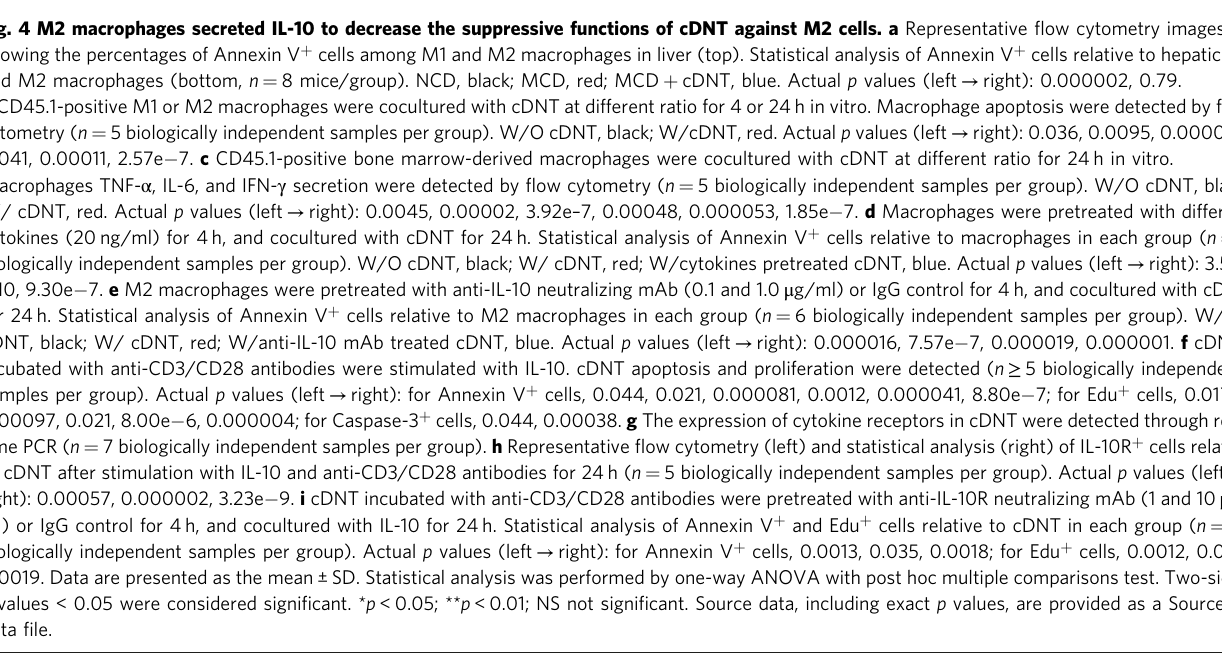
Fig. 4 M2 macrophages secreted IL-10 to decrease the suppressive functions of cDNT against M2 cells. a Representative fl ow cytometry images showing the percentages of Annexin V + cells among M1 and M2 macrophages in liver (top). Statistical analysis of Annexin V + cells relative to hepatic M1 and M2 macrophages (bottom, n = 8 mice/group). NCD, black; MCD, red; MCD + cDNT, blue. Actual p values (left → right): 0.000002, 0.79. b CD45.1-positive M1 or M2 macrophages were cocultured with cDNT at different ratio for 4 or 24 h in vitro. Macrophage apoptosis were detected by fl ow cytometry ( n = 5 biologically independent samples per group). W/O cDNT, black; W/cDNT, red. Actual p values (left → right): 0.036, 0.0095, 0.000029, 0.041, 0.00011, 2.57e − 7. c CD45.1-positive bone marrow-derived macrophages were cocultured with cDNT at different ratio for 24 h in vitro. Macrophages TNF- α , IL-6, and IFN- γ secretion were detected by fl ow cytometry ( n = 5 biologically independent samples per group). W/O cDNT, black; W/ cDNT, red. Actual p values (left → right): 0.0045, 0.00002, 3.92e – 7, 0.00048, 0.000053, 1.85e − 7. d Macrophages were pretreated with different cytokines (20 ng/ml) for 4 h, and cocultured with cDNT for 24 h. Statistical analysis of Annexin V + cells relative to macrophages in each group ( n = 6 biologically independent samples per group). W/O cDNT, black; W/ cDNT, red; W/cytokines pretreated cDNT, blue. Actual p values (left → right): 3.54e − 10, 9.30e − 7. e M2 macrophages were pretreated with anti-IL-10 neutralizing mAb (0.1 and 1.0 μ g/ml) or IgG control for 4 h, and cocultured with cDNT for 24 h. Statistical analysis of Annexin V + cells relative to M2 macrophages in each group ( n = 6 biologically independent samples per group). W/O cDNT, black; W/ cDNT, red; W/anti-IL-10 mAb treated cDNT, blue. Actual p values (left → right): 0.000016, 7.57e − 7, 0.000019, 0.000001. f cDNT incubated with anti-CD3/CD28 antibodies were stimulated with IL-10. cDNT apoptosis and proliferation were detected ( n ≥ 5 biologically independent samples per group). Actual p values (left → right): for Annexin V + cells, 0.044, 0.021, 0.000081, 0.0012, 0.000041, 8.80e − 7; for Edu + cells, 0.017, 0.00097, 0.021, 8.00e − 6, 0.000004; for Caspase-3 + cells, 0.044, 0.00038. g The expression of cytokine receptors in cDNT were detected through real- time PCR ( n = 7 biologically independent samples per group). h Representative fl ow cytometry (left) and statistical analysis (right) of IL-10R + cells relative right): 0.00057, 0.000002, 3.23e − 9. i cDNT incubated with anti-CD3/CD28 antibodies were pretreated with anti-IL-10R neutralizing mAb (1 and 10 μ g/ ml) or IgG control for 4 h, and cocultured with IL-10 for 24 h. Statistical analysis of Annexin V + and Edu + cells relative to cDNT in each group ( n = 5 biologically independent samples per group). Actual p values (left → right): for Annexin V + cells, 0.0013, 0.035, 0.0018; for Edu + cells, 0.0012, 0.037, 0.0019. Data are presented as the mean ± SD. Statistical analysis was performed by one-way ANOVA with post hoc multiple comparisons test. Two-sided p values < 0.05 were considered signi fi cant. * p < 0.05; ** p < 0.01; NS not signi fi cant. Source data, including exact p values, are provided as a Source data fi